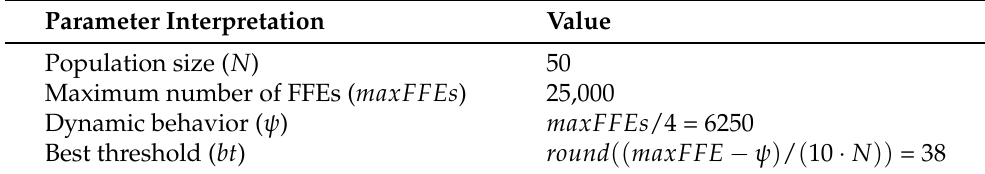
Table 2. The eHHO control parameters